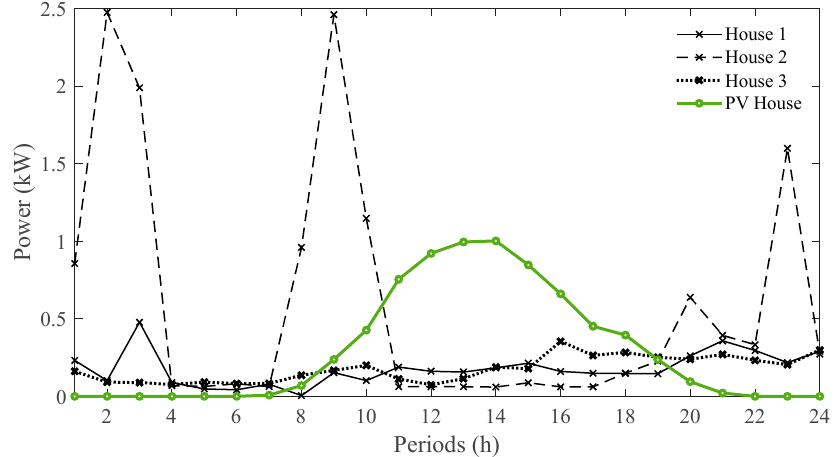
Figure 5. Profiles used in the case study. Ranges of power (in kW): house 1 [0.18–0.48], house 2 [0.06–2.50], house 3 [0.07–0.36], PV (house) [0–1] [36].